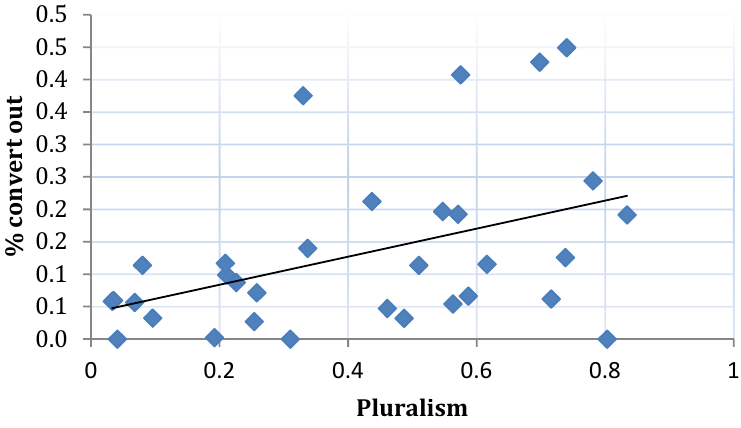
Figure 1. Converting out as a function of religious